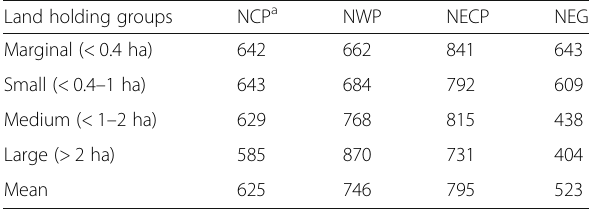
Table 4 Agricultural income of different land-holding classes in